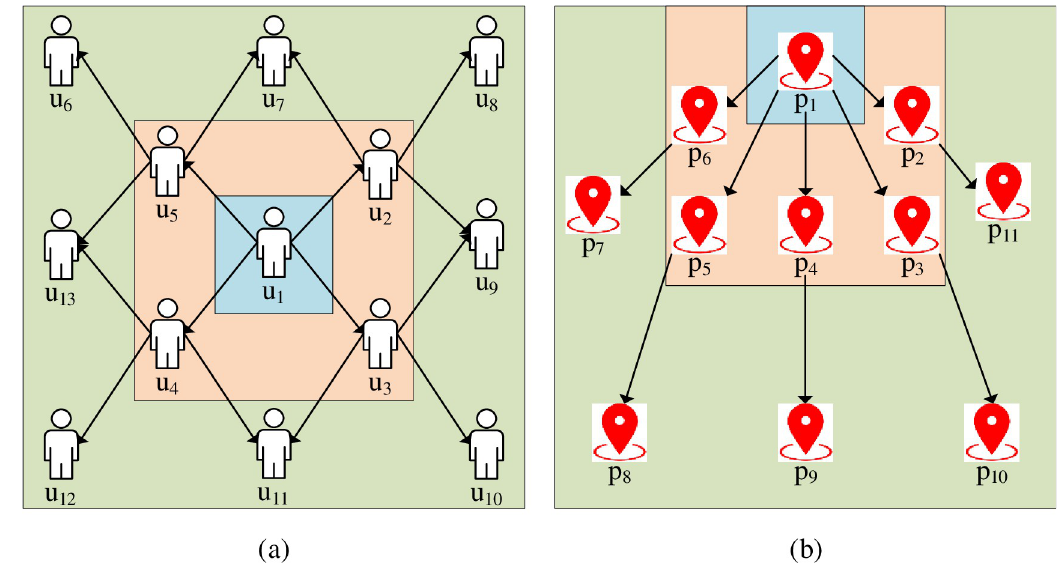
Fig 4. Impact of user POI (a: social impact; b: environmental